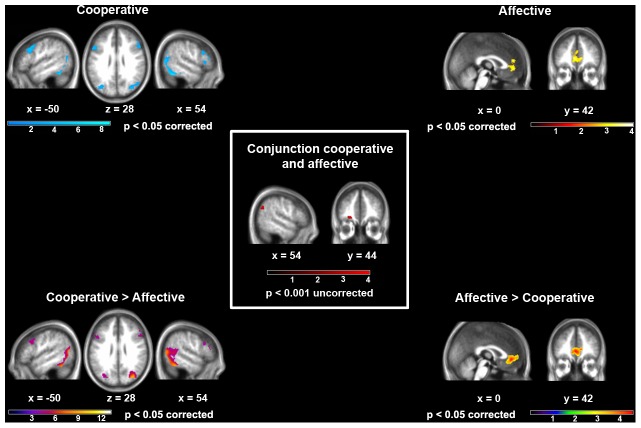
The effect of interaction goal on the neural processing of human social interactions.The brain regions activated during the observation of either cooperative (top left) or affective (top right) social interactions, as well as those more strongly activated by cooperative vs. affective (bottom left) or affective vs. cooperative (bottom right) social interactions (p<0.05 FWE corrected for multiple comparisons). The brain regions that were commonly activated while observing cooperative and affective interactions (p<0.001 uncorrected for multiple comparisons) are shown in the centre of the figure. Functional activations have been overlaid on an average-brain from individual subjects' T1-weighted images. The distance (in mm) from the origin of the MNI coordinate-system located in the anterior commissure is reported below each section.